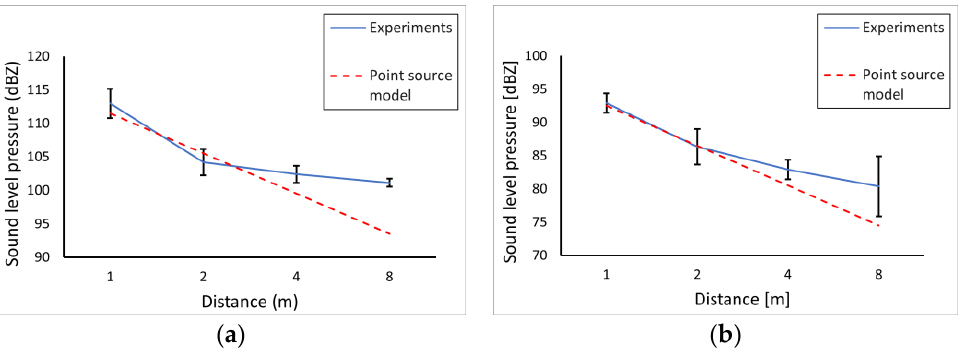
Figure 5. Comparison experimental results and point source model at various values of nozzle-to- sound level meter distance for ( a ) standard and ( b ) silent nozzles; data points represent mean SPL value over the dataset acquired at the same distance and varying the angle of inclination; the error bars represent doubled standard deviation.